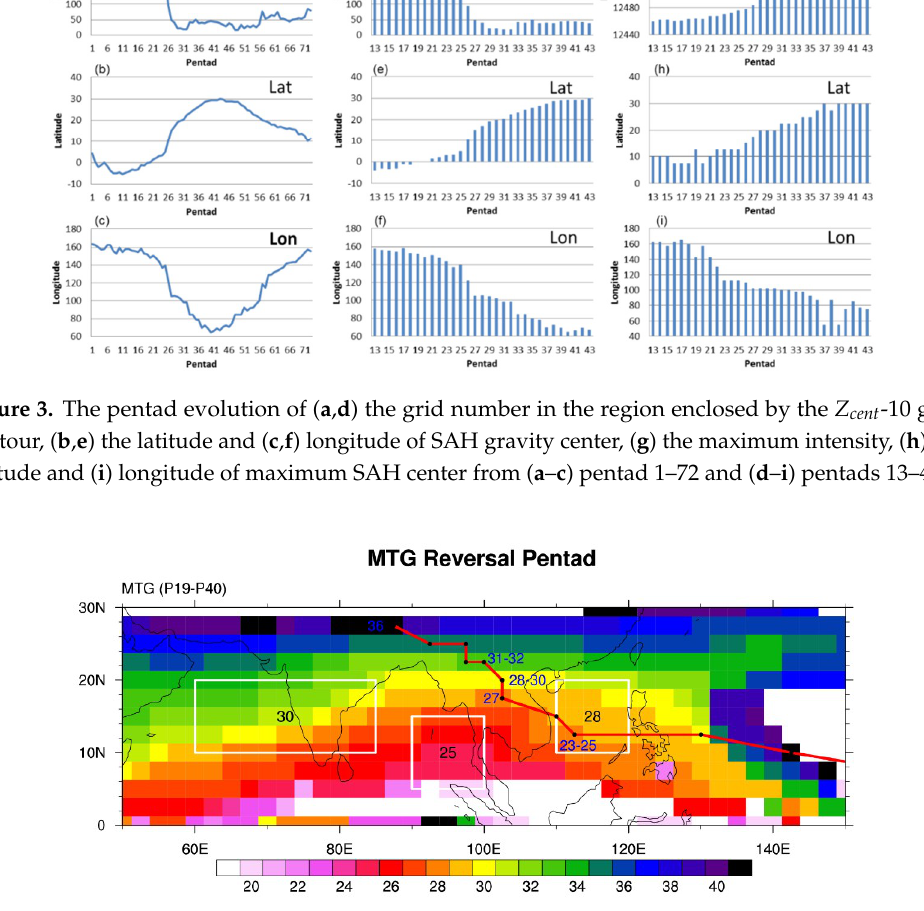
Figure 4. The transition pentads of the MTG from negative to positive during the spring-to-summer transition (P19–40) (shading; units: pentad) and the location of SAH maximum intensity center at 200 hPa (black dots) and the moving track (red lines) are also shown from Pentad 21 to Pentad 36. Pentads are shown by blue numbers. White boxes from West to East indicate the regions of ISM, BOB and SCS, respectively. Number inside each box is the domain average of the MTG transition pentads.